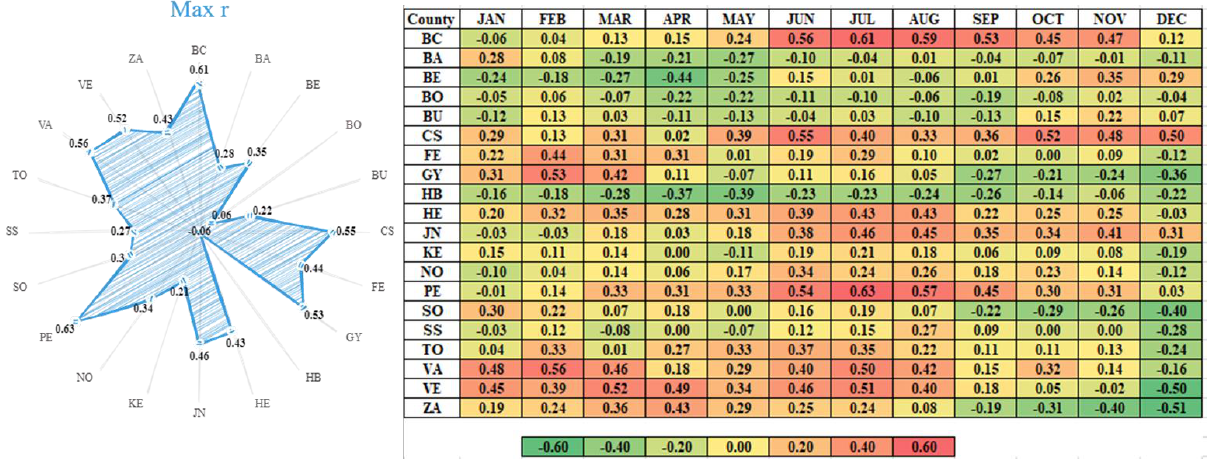
Figure 8. Correlation values between the SSYR and SPEI during the sunflower growing cycle (2000–2010) ( right table), and max correlation (Max. r) between the SSYR and SPEI ( left figure).